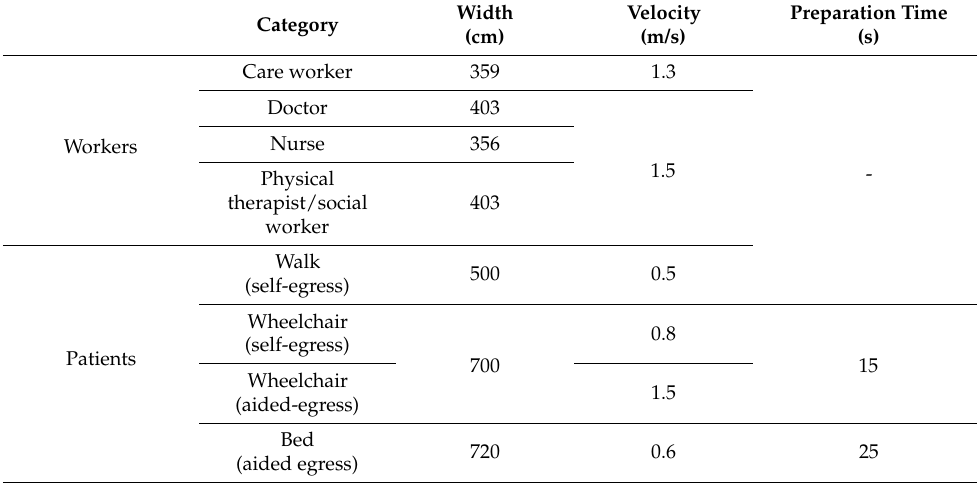
Table 2. Characteristics of workers and patients.